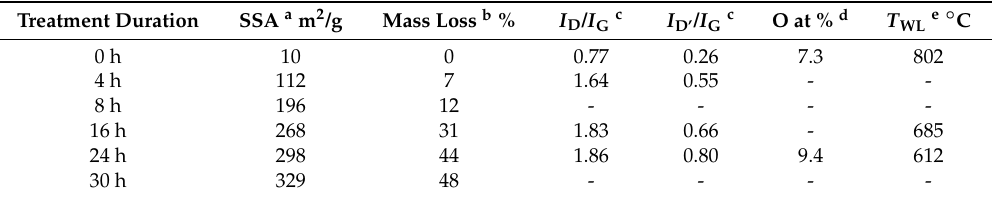
Table 1. The physical chemistry properties of samples as a function of the acid treatment duration.